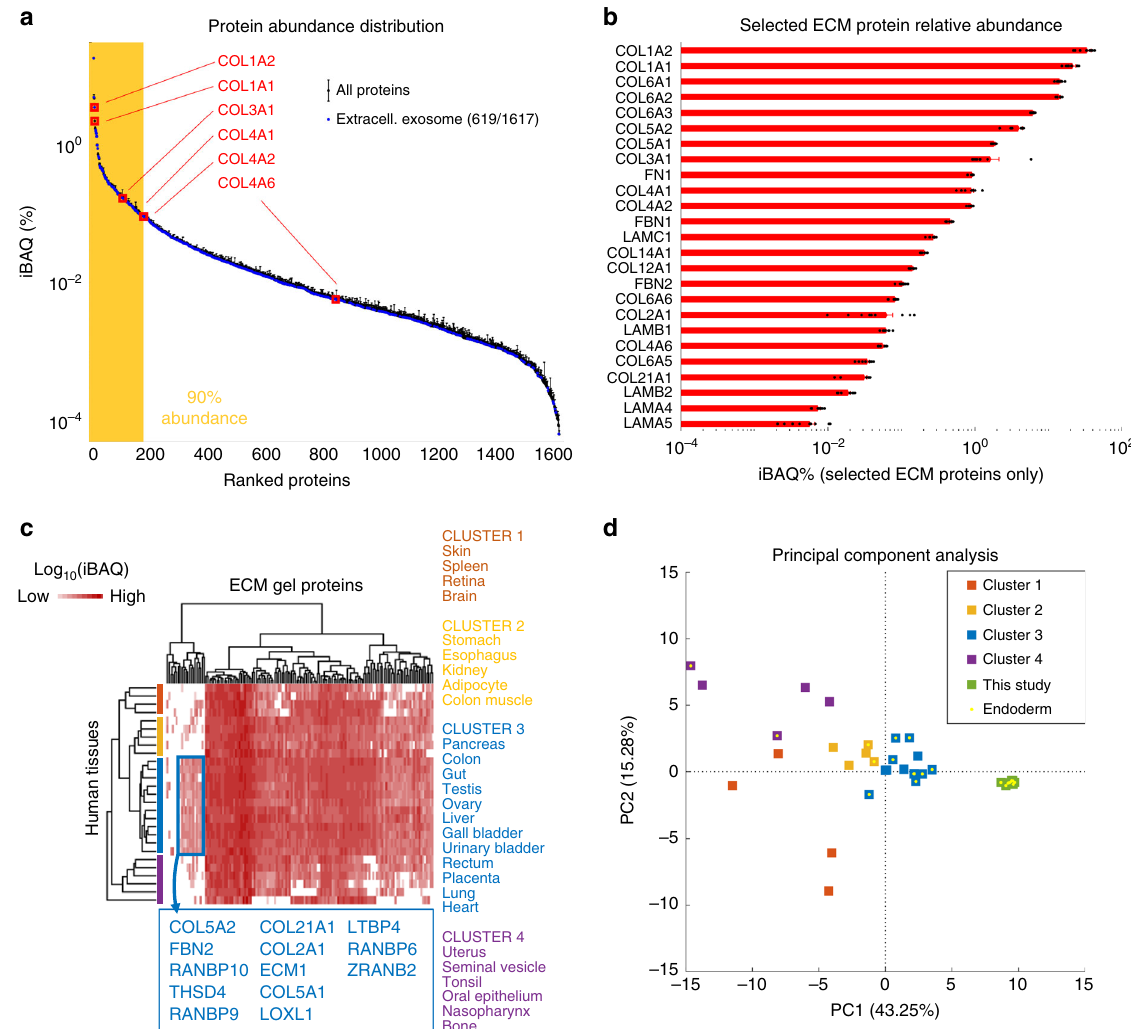
Fig. 2 ECM proteomic analysis. a Protein abundance range, with 619 (on 1617 total) proteins mapped to GO-CC:0070062~extracellular exosomes highlighted. Yellow-shaded area represents the range covering 90% of total protein abundance. Collagens analyzed in Fig. 1e are also highlighted. Mean ± SEM ( n = 3 batches, with three technical replicates each). b Relative abundance of selected ECM proteins. Black dots represent individual data points. Mean± SEM ( n = 3 batches, with three technical replicates each). c Hierarchical clustering analysis of mass spectrometry native human tissue data from a draft map of the human proteome, conducted for proteins in our data mapped to GO-CC:0031012~ECM. Four main clusters are identi fi ed whose color- coded tissues are reported on the right. A small group of proteins especially expressed in cluster 3 is highlighted. A fully detailed version of this heat map is reported in Supplementary Fig. 3. d Principal component analysis (PCA) of data from native human tissue reported in ( c ), and of data generated in this study. Tissues and samples having endodermal origin are also